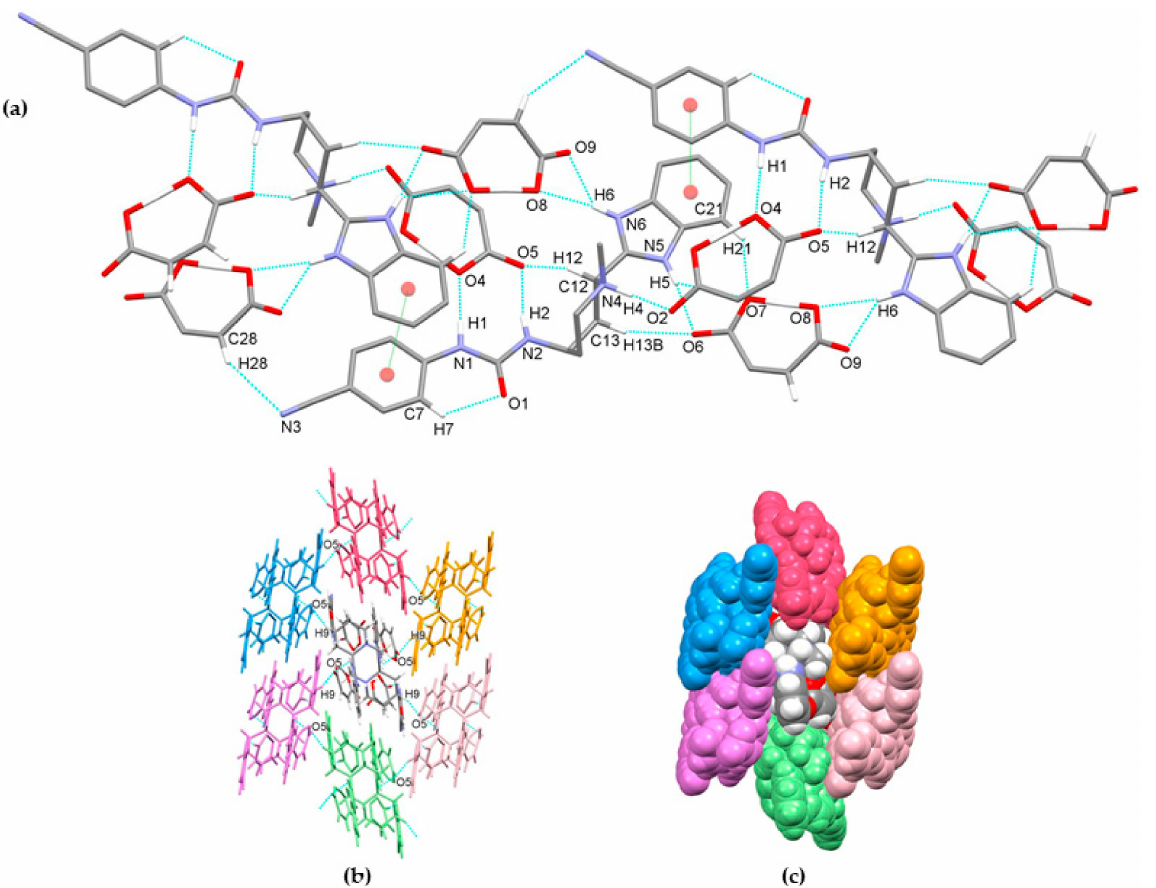
Figure 12. Hydrogen-bond architecture in the glasdegib dimaleate: ( a ) chain formation along c axis; ( b ) packing of chains along ab plane via C9–H9 · · · O5 interactions; ( c ) space-filled presentation of packing of chains (arbitrary colors). Hydrogen bonds are represented by dashed blue lines and π · · · π interactions by dashed green lines. Hydrogen atoms not involved in the motif shown have been omitted for